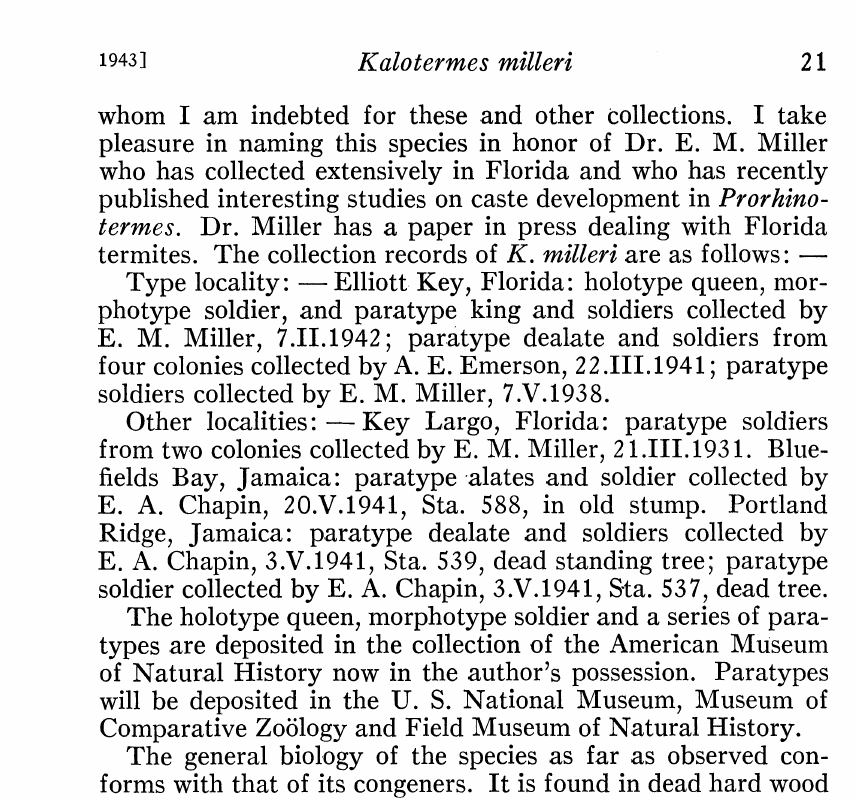
FIG. 1. Head and pronotum of imago from above. FxG. 2. Head of imago from side. FxG. 3. Head and pronotum of soldier from above. FxG. 4. Head and pronotum of soldier from side. FG. 5. Head of soldier from